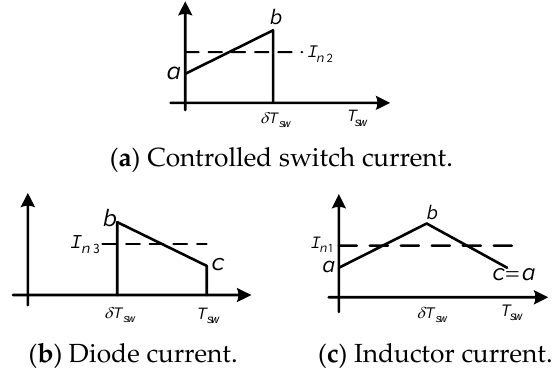
Figure 6. Current waveforms generated by converter cell 1-1 during CCM.